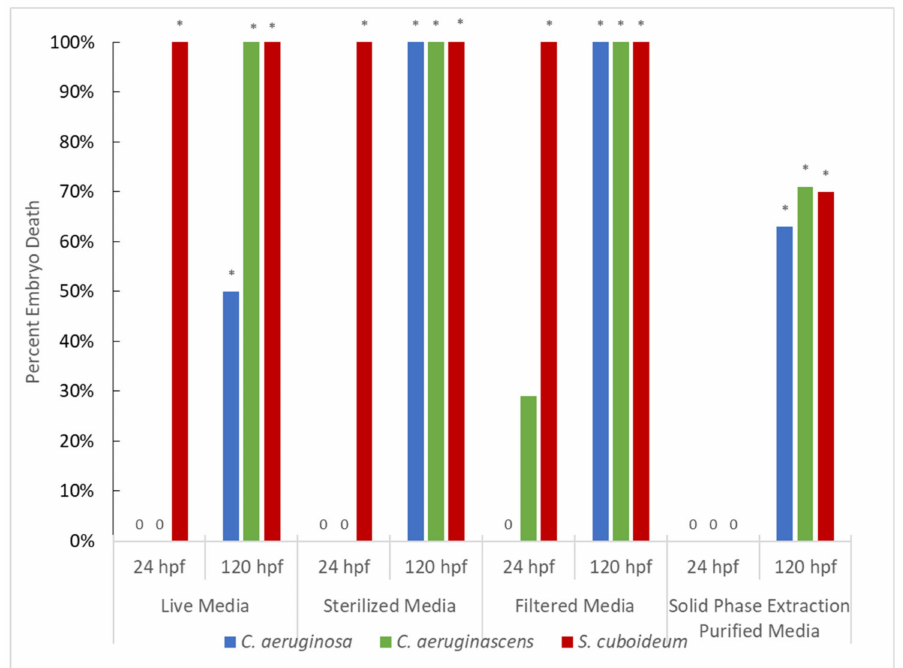
Figure 3. Percent Embryo Death After Exposure to Pigments from Fungi Grown in Liquid Media at 24 and 120 hpf. Asterisks denote significant differences from control at the α = 0.05 level, with all significant values having a p -value of <0.0001, apart from live media C. aeruginosa at 120 hpf which had a p -value of 0.0028. Zeros indicate there was no embryo mortality in that